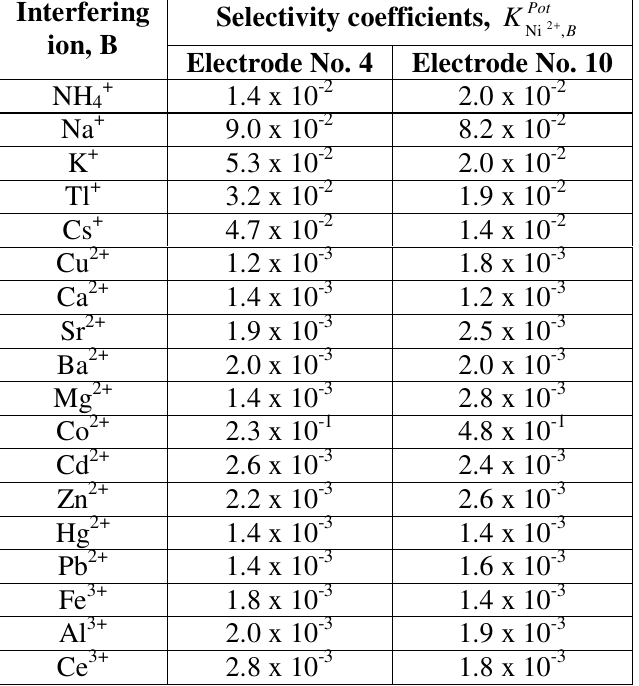
for Ni 2+ -selective sensors K Table 3 : Selectivity coefficient values Pot , Ni 2 + B (electrode nos. 4 and 10) as calculated by Match Potential Method Interfering K Selectivity coefficients, Pot , Ni 2 + B ion, B Electrode No.